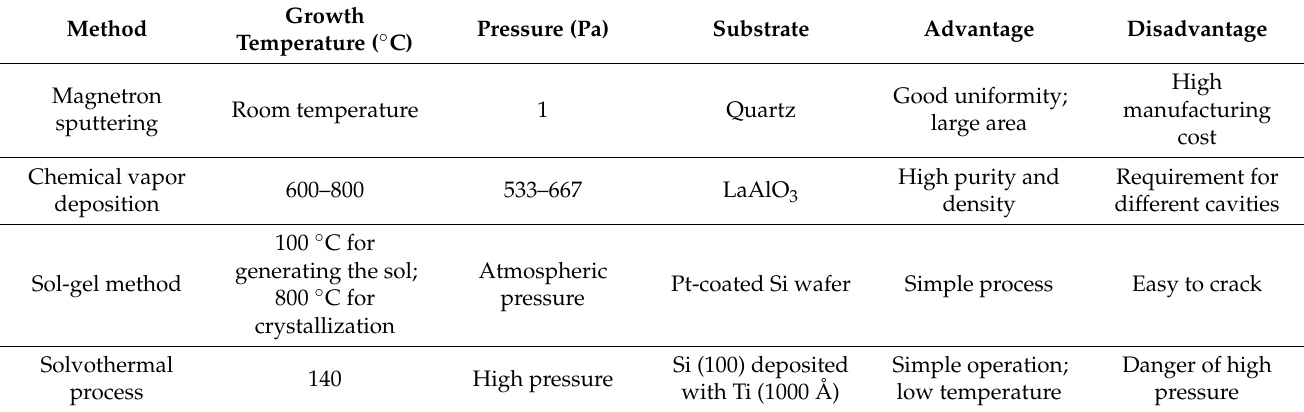
Table 2. Typical growth methods for the preparation of BaTiO 3 thin films